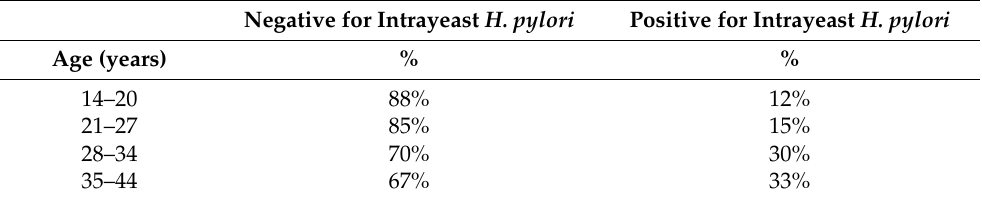
Table 2. Distribution and percentages of term pregnant women positive for vaginal intra-yeast H. pylori according to age ranges.